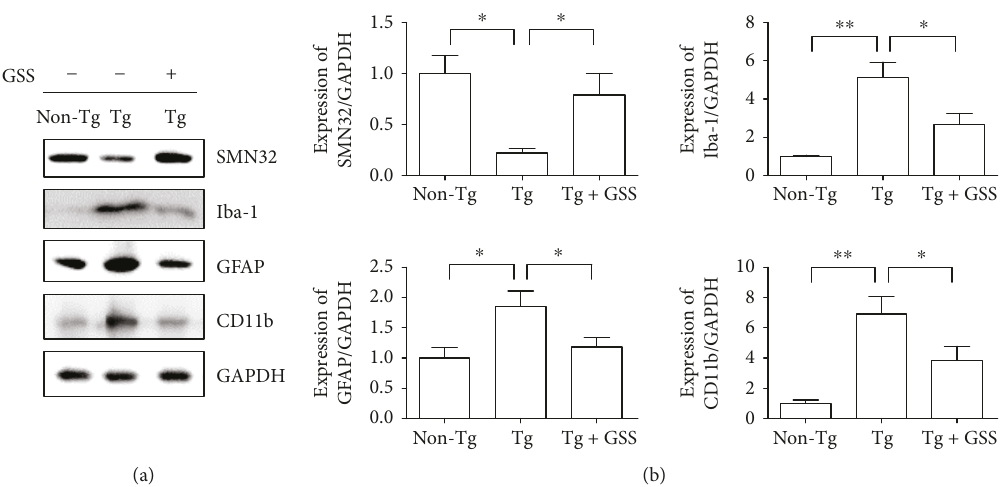
Figure 1: GSS administration increases motor neuron survival and modulates in fl ammation in the spinal cord of hSOD1 G93A transgenic (Tg) mice. (a) Representative Western blot showing the expression of SMN (marker of motor neurons), Iba-1 or CD11b (microglia activation markers), and GFAP (astrocyte activation marker) in the spinal cord of control (Non-Tg), hSOD1 G93A Tg, and Tg mice treated with GSS (Tg+GSS). GAPDH was used as a loading control. (b) Quantitative analysis of the normalized levels of SMN, Iba-1, GFAP, and CD11b against GAPDH. Data represent the means ± SEM ( n = 4 ) and were evaluated by one-way ANOVA and Newman-Keuls ’ post hoc test. ∗ p < 0 05 and ∗∗ p < 0 01